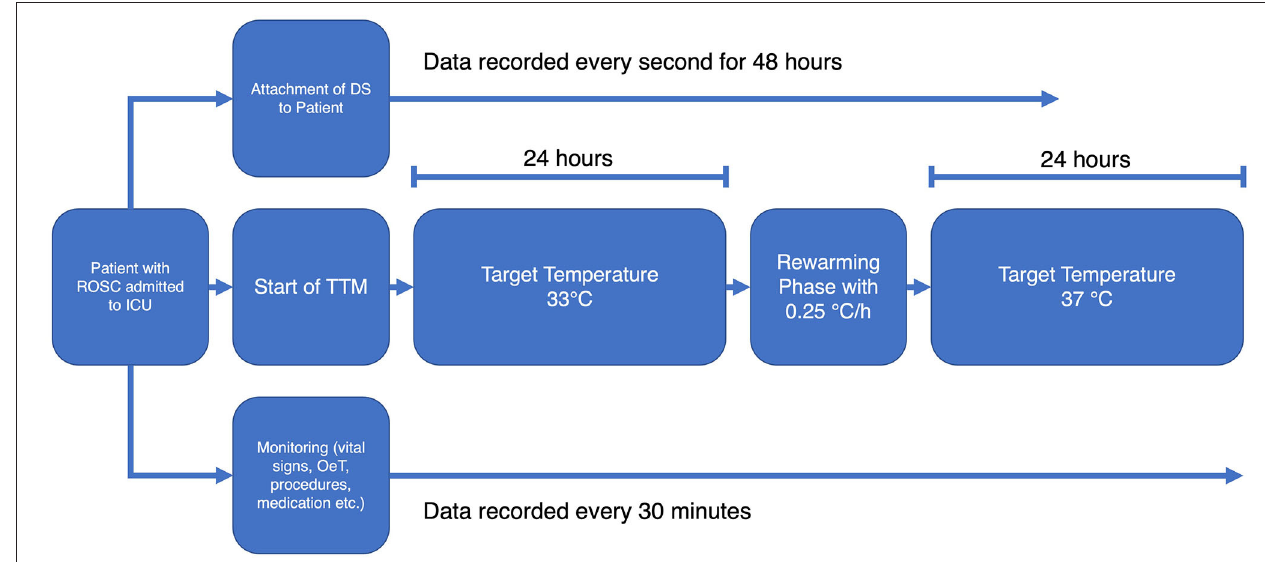
FIGURE 1 | Flowchart of the study protocol.